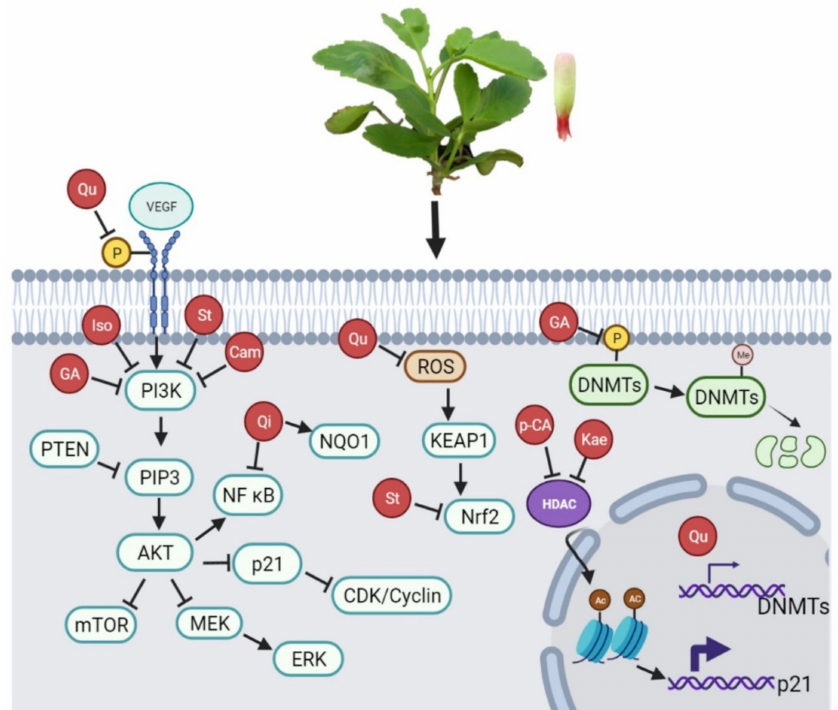
Figure 4. Pathways in which K. pinnata regulates gene expression. Phytochemicals of K. pinnata are involved in processes such as proliferation, apoptosis, cell migration, angiogenesis, metastasis, promoter methylation, inhibition of nuclear and cytoplasmic DNMTs, oxidative stress, and autophagy (see text for details). Source: Image created with